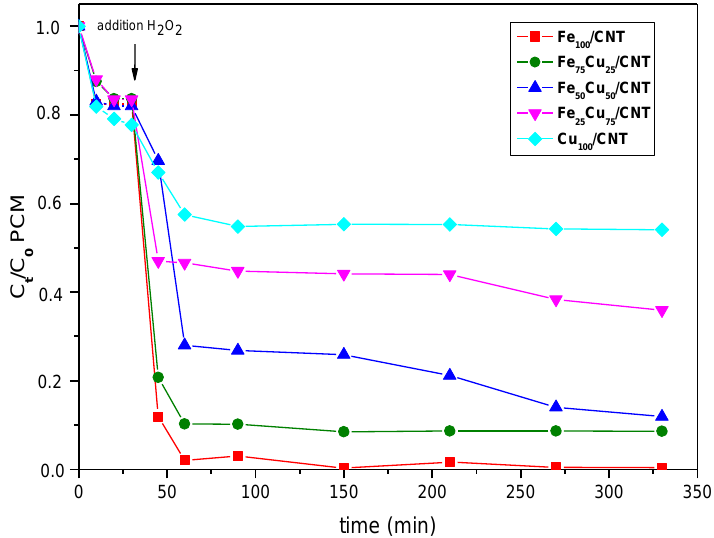
Figure 7. Decomposition kinetics of paracetamol (PCM; C 0 = 50 mg/L) at 25 °C on Fe 100−x Cu x /CNT samples. C 0 of H 2 O 2 : 13.8 × 10 −3 mol/L. Initial pH: 3.